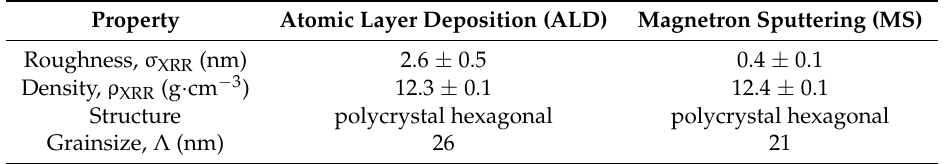
Figure 5. The estimated grain size by the Scherrer equation (left, ○ ) increases with coating thickness and saturates at Λ = 30 nm. The roughness evolution with increasing Ru film thickness is additionally shown (right, ∆ ). The filled symbols correspond to the MS coating. Table 1. Comparison of coating properties of a 57.5 nm thick ALD and a 50 nm thick MS Ru coating.